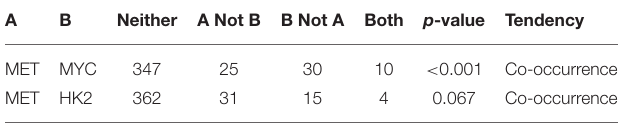
TABLE 1 | The trendency of MET, HK2, and MYC expression in gastric cancer tissues. A B